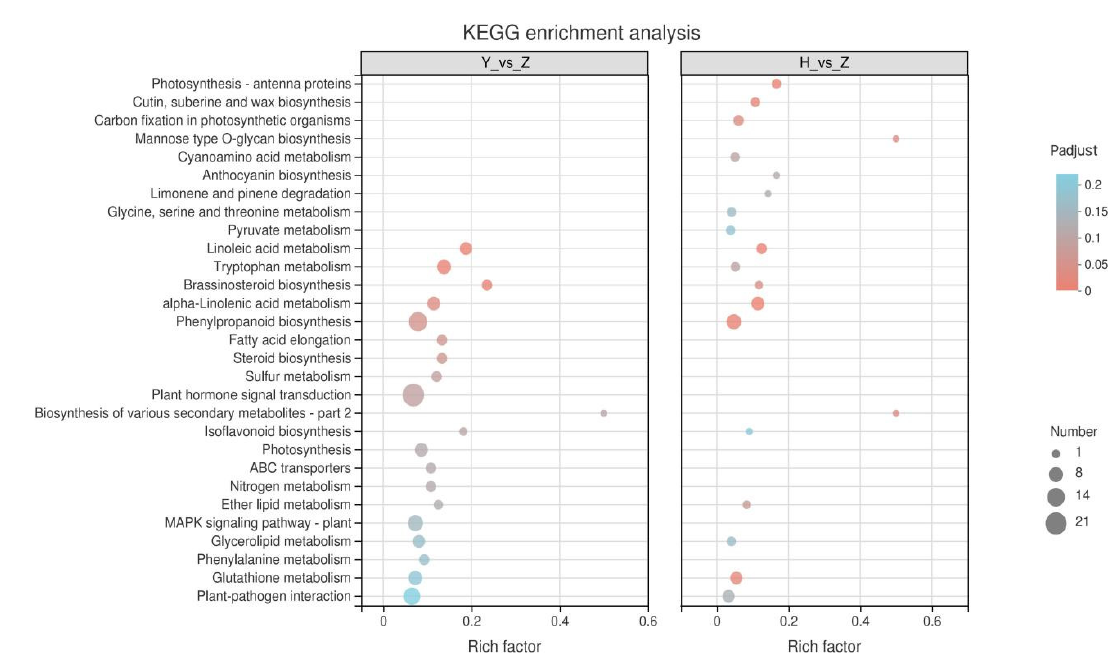
Figure 5. KEGG enrichment analysis of DEGs for the comparison of two kinds of pumpkin-grafted cucumber (H and Y) with self-rooted cucumber (Z), and the “Benjamini and Hochberg” test was used to detect significantly enriched KEGG terms (FDR < 0.05, p < 0.05).